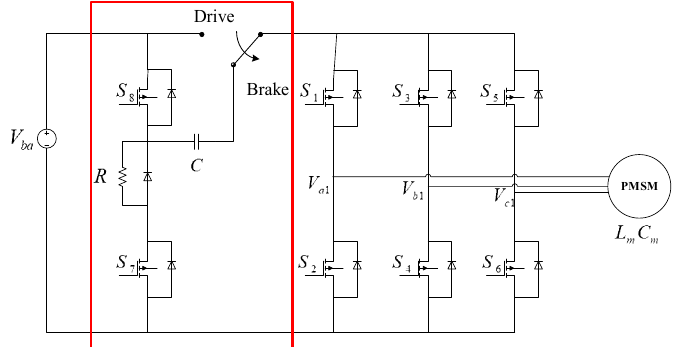
Figure 2. Active regenerative braking control scheme.